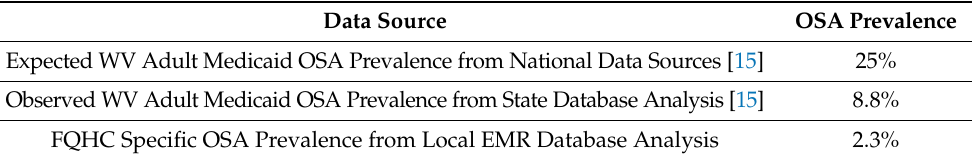
Table 5. National Estimate and Statewide OSA Prevalence Data Compared to Rural WV FQHC OSA Prevalence